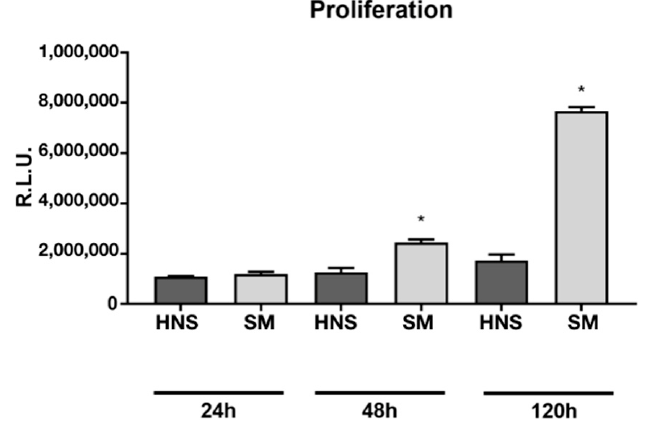
Figure 4. Cell proliferation assay measured using CellTiter-GLO at 24, 48, and 120 h, measuring the luminescence through a microplate reader. Values represent mean ± SEM. The symbol (*) indicates the statistical significance vs. HNS surface, considering a p -value < 0.05.